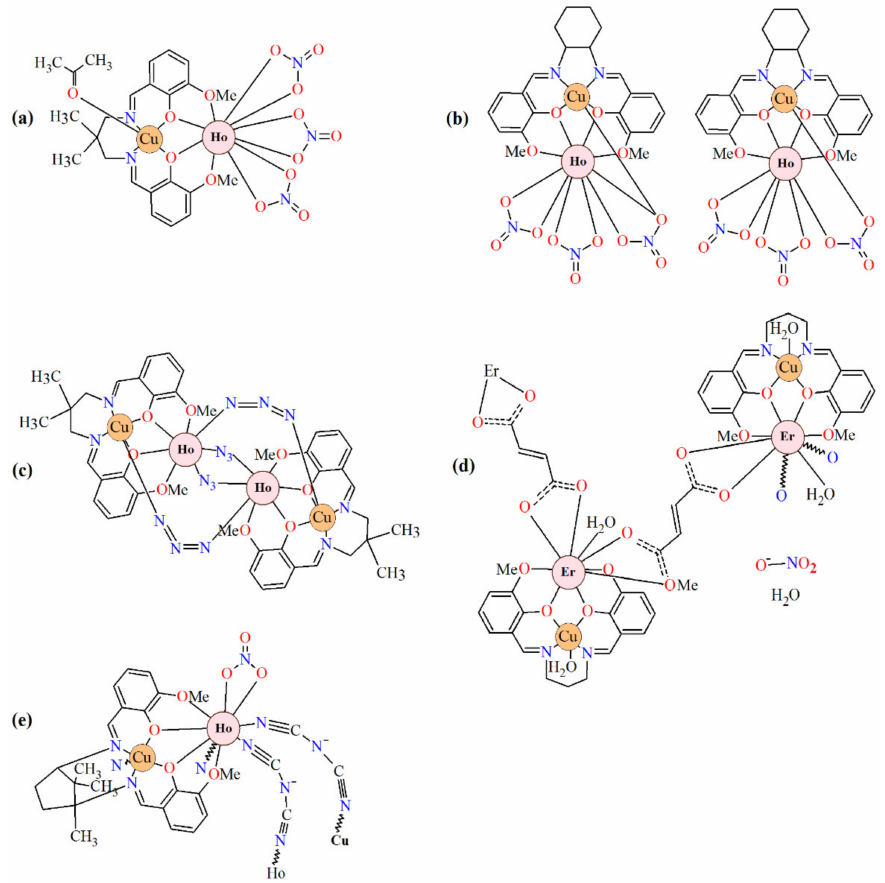
Figure 2. Chemical diagrams of selected heteronuclear complexes Cu II -Ho III /Er III including salen– type Schiff base ligands: ( a ) [Cu(L)(ace)Ln(NO 3 ) 3 ], ( b ) [Cu(L)Ln(NO 3 ) 3 ], ( c ) [Cu 2 (valdmpn) 2 Ln 2 (N 3 ) 6 ] · 2(MeOH) 0.5 , ( d ) [LCu II Er III (H 2 O) 2 (fum)]NO 3 · 3H 2 O, ( e ) [LCuHo(dca) 2 (NO 3 )] n (where Ln = Ho,